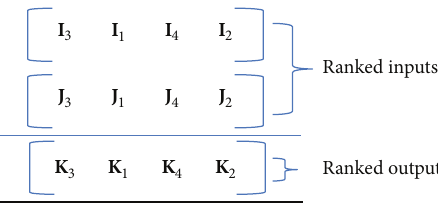
Figure 2: Ranked received inputs and output.